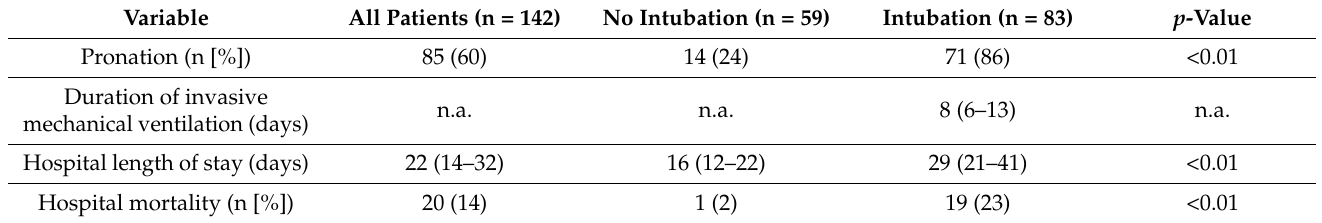
Table 2. Patients’ outcomes.